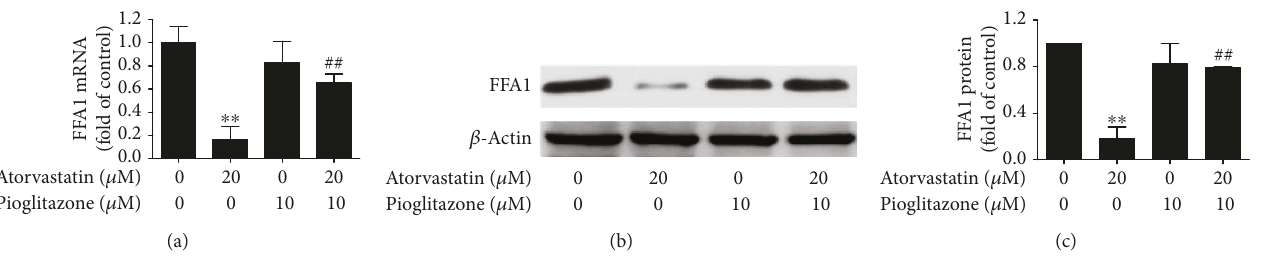
Figure 4: Pioglitazone increased FFA1 expression reduced by atorvastatin in INS-1 cells. (a) qRT-PCR assay analysis of FFA1 expression in INS-1 cells treated with atorvastatin and pioglitazone for 24 h. (b and c) Western blot assay analysis of FFA1 expression in INS-1 cells treated with atorvastatin and/or pioglitazone for 24 h. β -Actin was detected as control. Each experiment was repeated at least three times. ∗∗ P < 0 01 compared to 0 μ M atorvastatin and 0 μ M pioglitazone treatment. ## P < 0 01 compared to 20 μ M atorvastatin treatment alone.